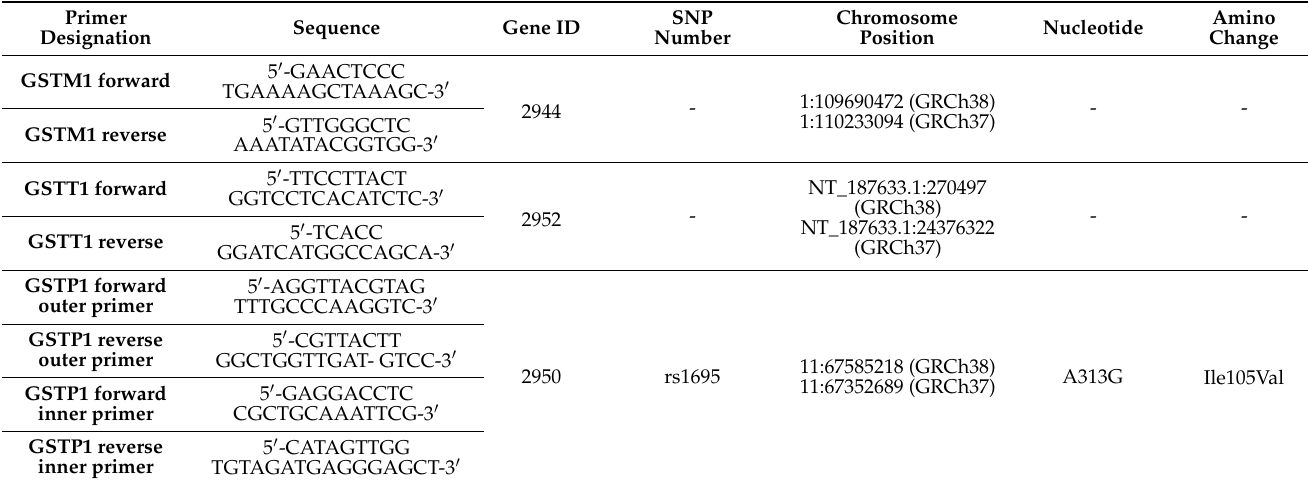
Table 1. Characteristics of the genes under study.